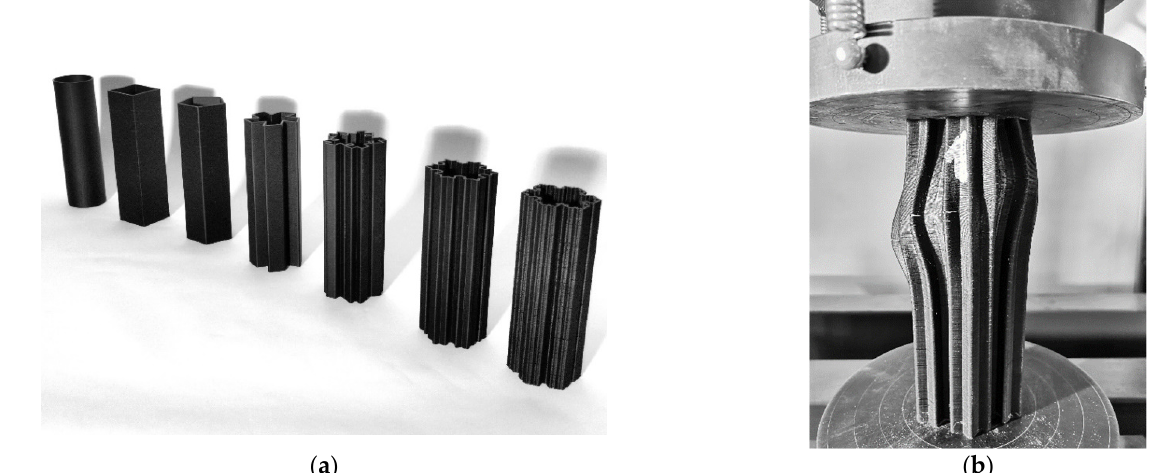
Figure 5. 3D printed column formworks ( a ); deformation of a concrete-plastic column during compression ( b ) Images created by A. Skoratko.